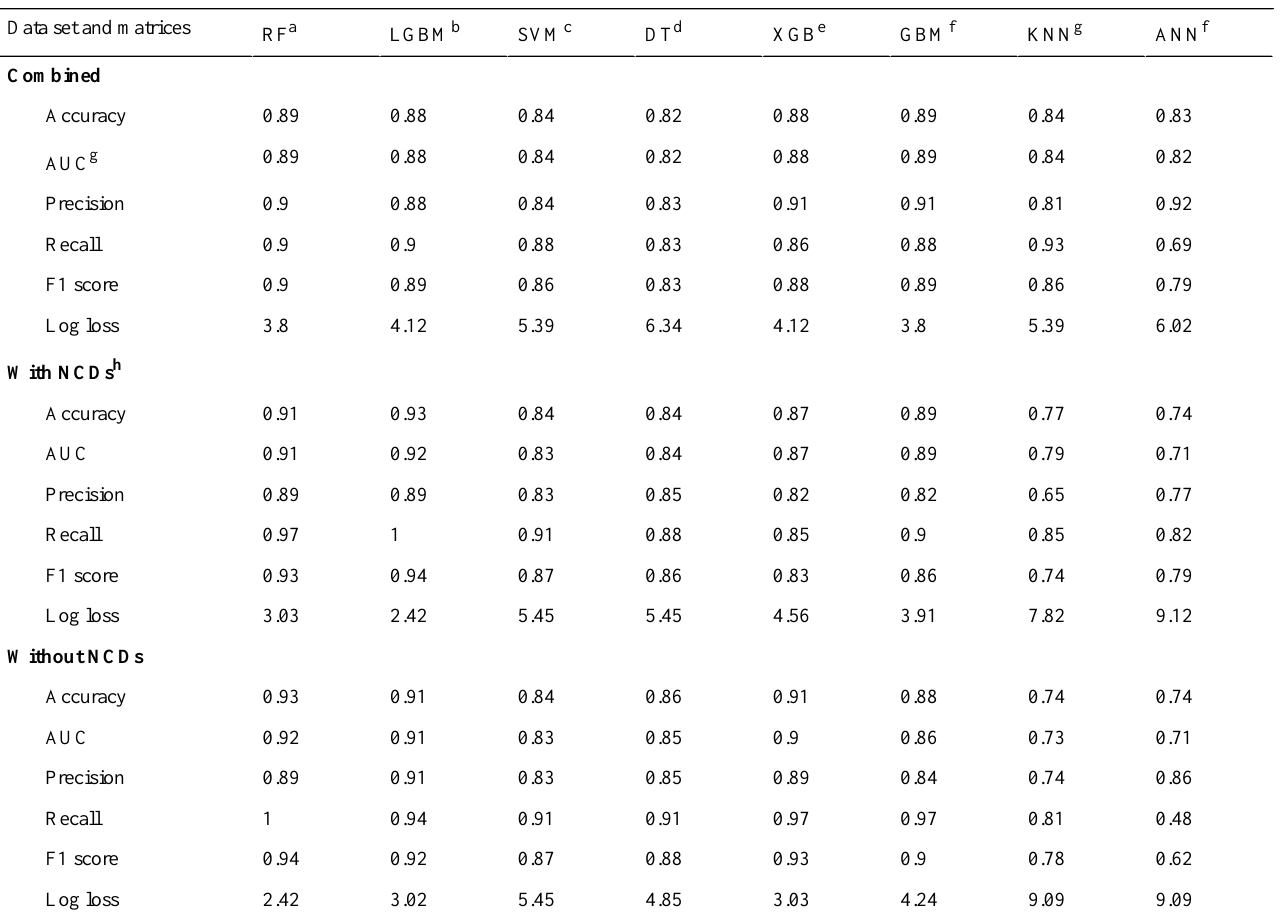
Table 2. Accuracy and evaluation matrices for each data